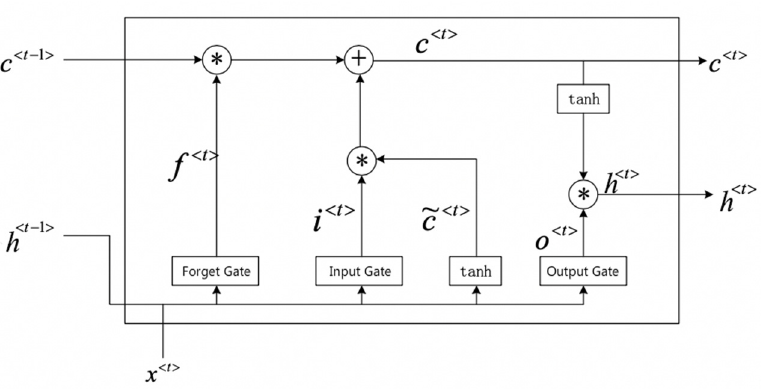
Figure 2. The internal structure of LSTM.